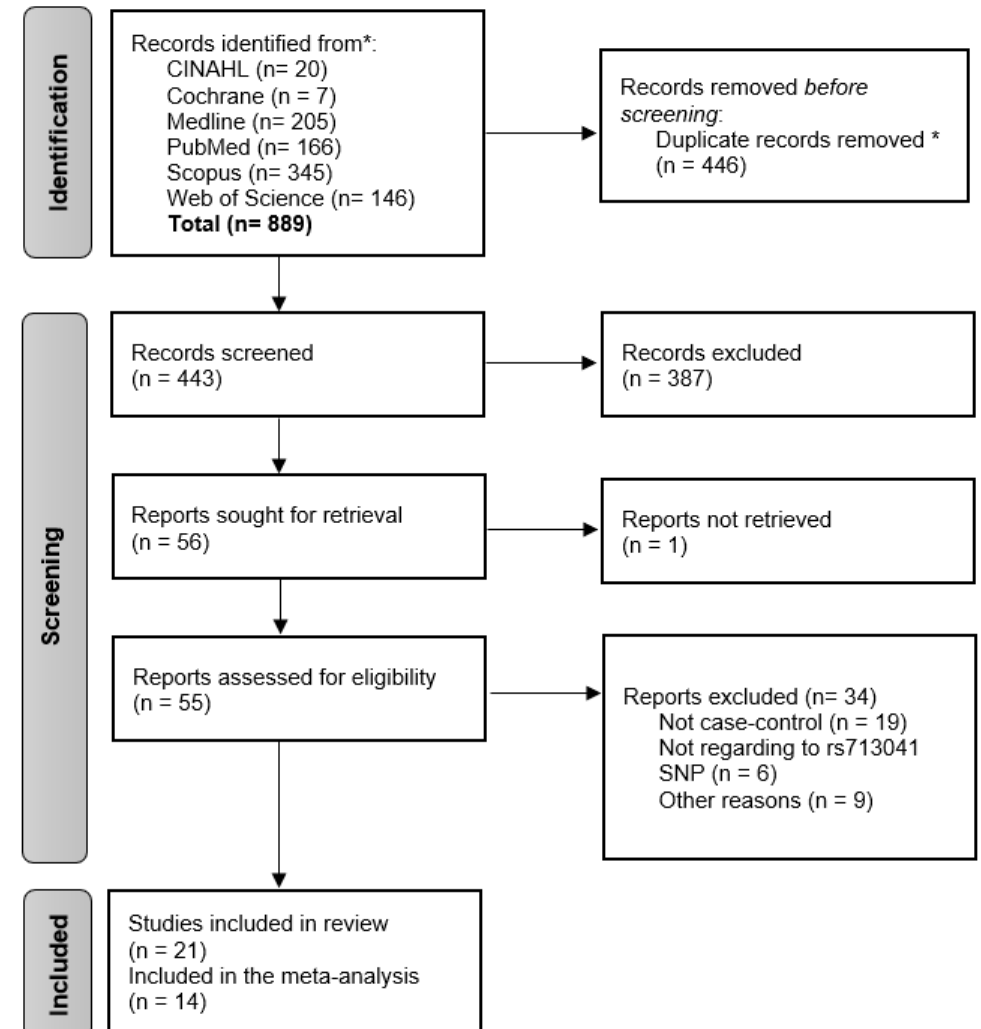
Figure 1. Flow-diagram showing the study selection procedure. * Using Zotero.